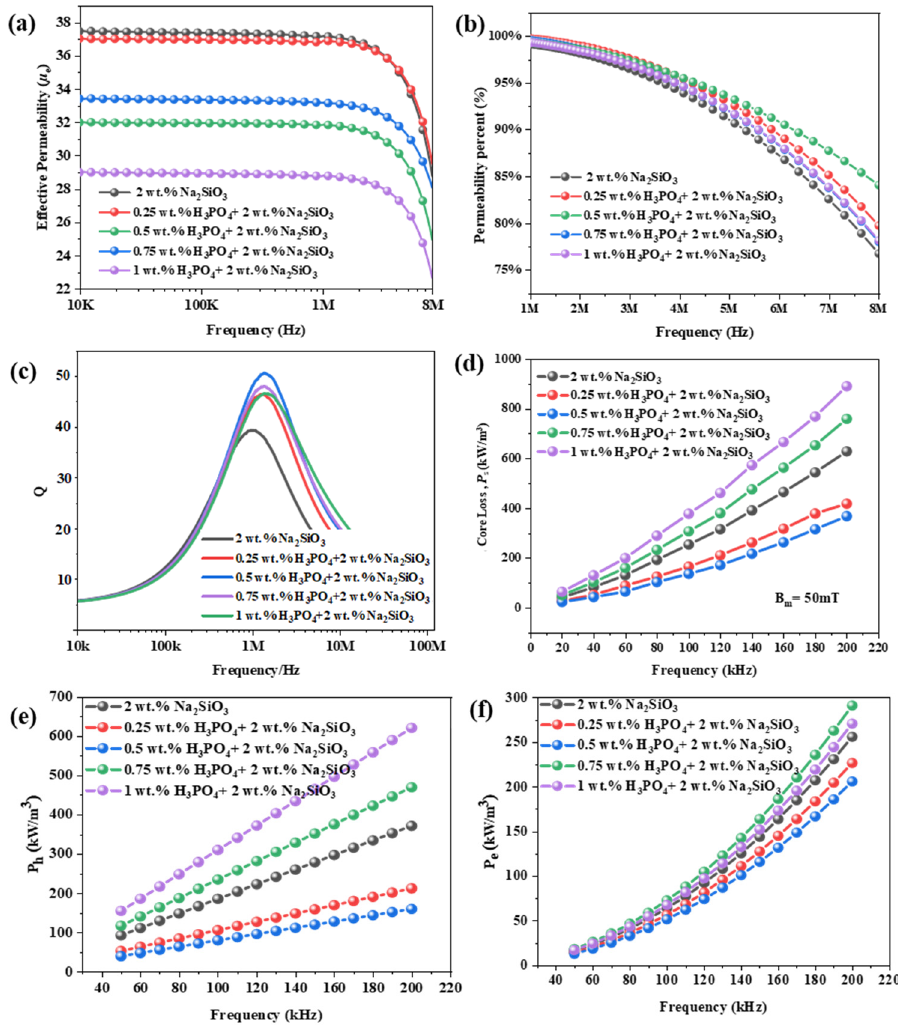
Figure 5. Frequency dependences of the ( a ) μ e , ( b ) permeability percent, ( c ) Q , ( d ) P s , ( e ) P h , ( f ) P e for SMCs after coating with different H 3 PO 4 concentration s.